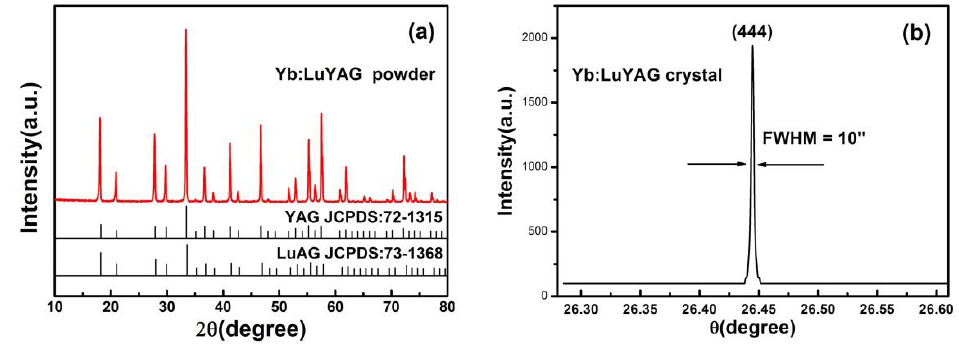
Figure 2. ( a ) X-ray diffraction (XRD) of Yb:LuYAG polycrystal powder and ( b ) the X-ray rocking curve.